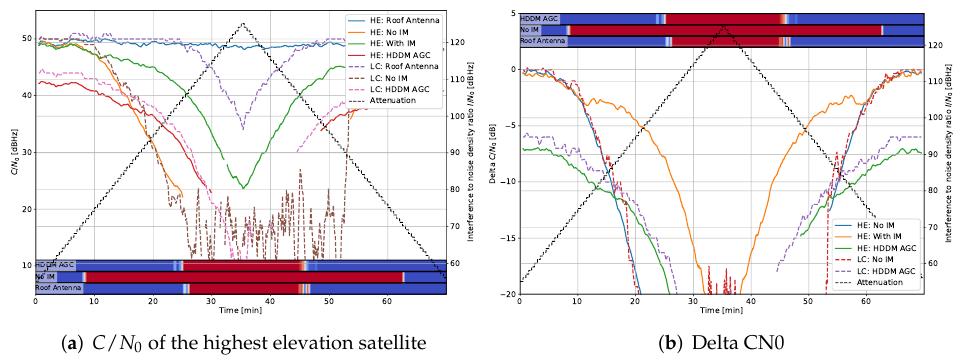
Figure A4. Interference #4: Fast frequency hopper with a dwell time of 1us and a frequency range of 35MHz with GPS L1/CA.